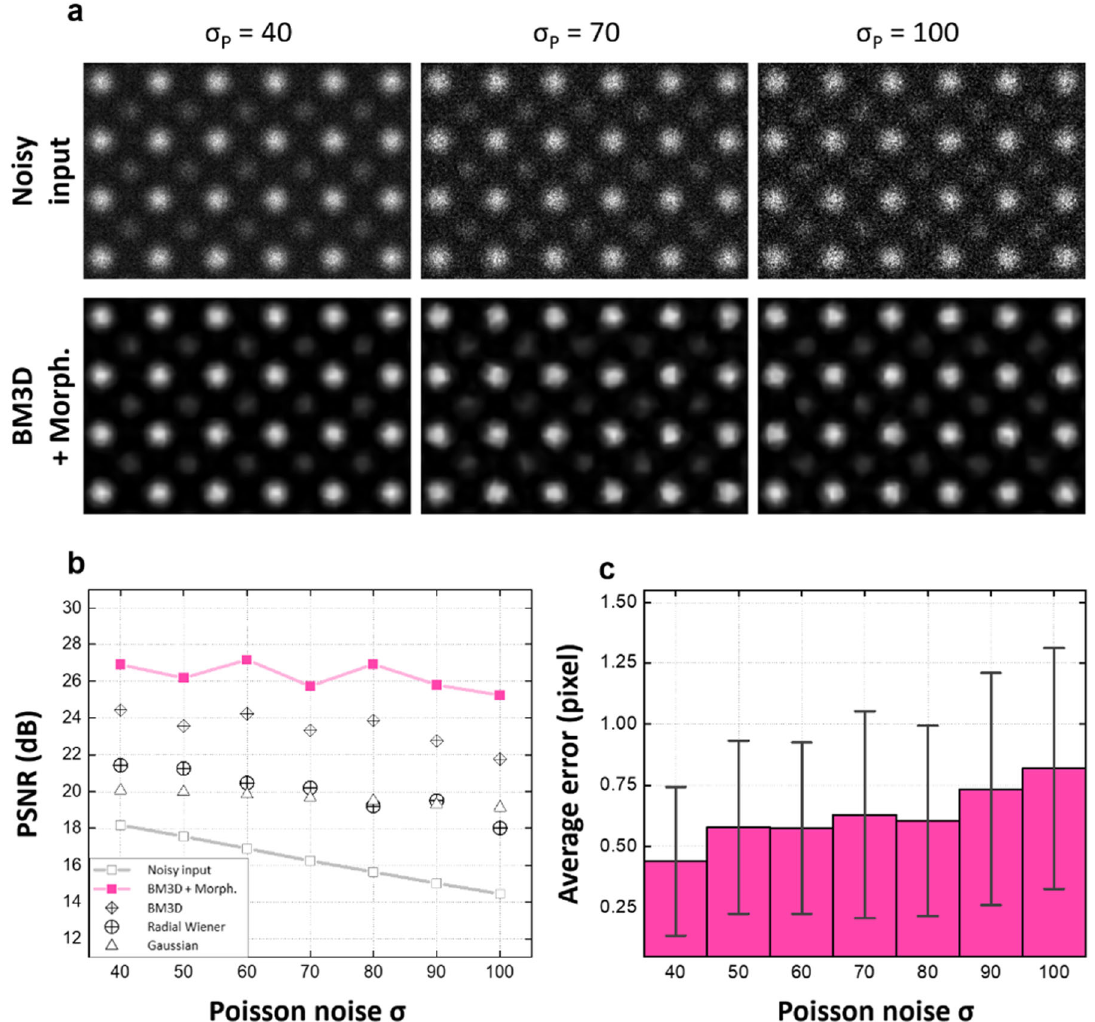
Fig. 4 Performance of noise removal and precision of atomic positions depending on the input noise. a Simulated HAADF – STEM images corrupted by arti fi cial Poisson noise and corresponding denoised images using the BM3D method and morphological fi lter. b Dependencies of PSNR on the arti fi cial Poisson noise in input images, where σ P denotes the standard deviation of Poisson noise. c Precision of estimated atomic columns acquired using our proposed method depending on the arti fi cial Poisson noise. Black lines are one standard deviation of the